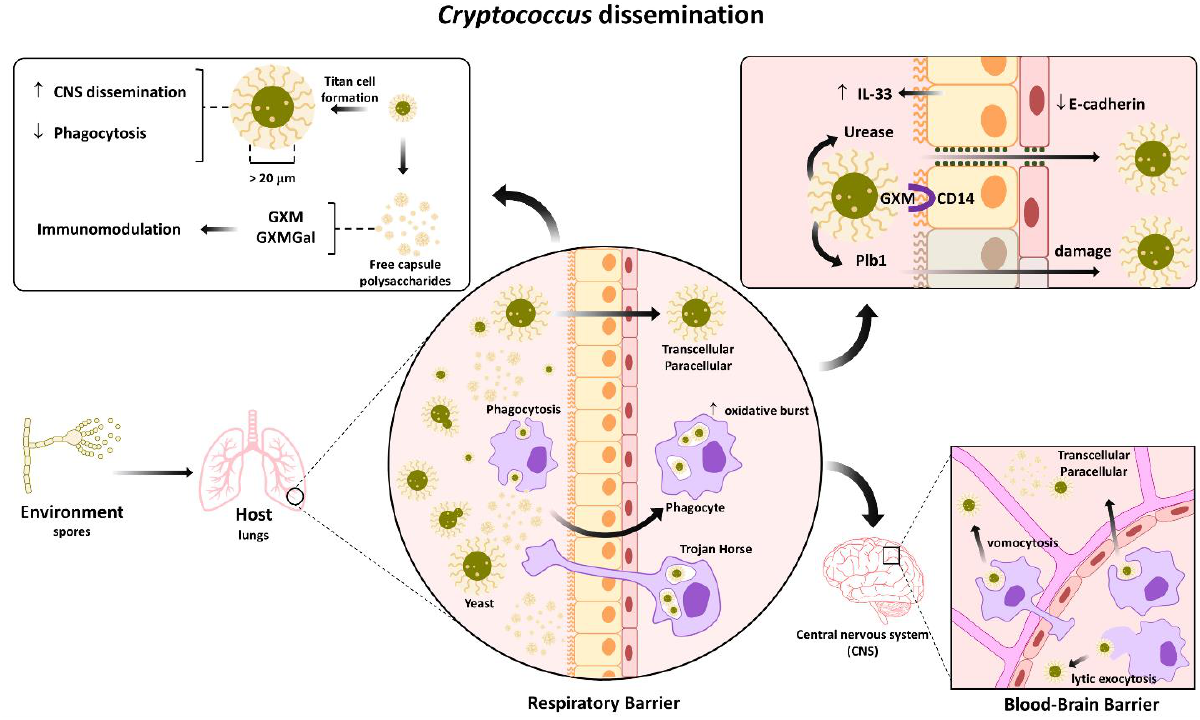
Figure 2. First morphological changes in Cryptococcus spp. inside the host and its dissemination mechanisms through the respiratory and blood – brain epithelial barriers. mechanisms through the respiratory and blood–brain epithelial